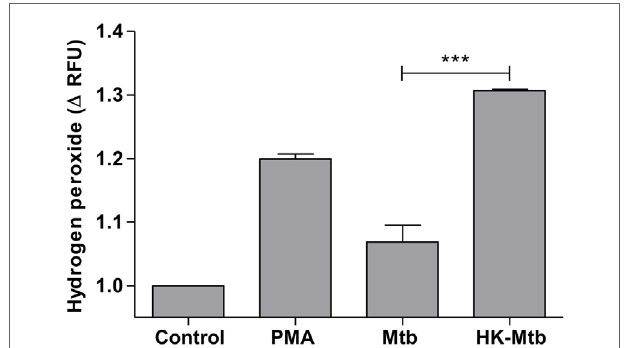
FigUre 4 | Mast cells stimulated with Mycobacterium tuberculosis (Mtb) shows low levels of hydrogen peroxide. HMC-1 cells were left unstimulated (control) or stimulated with PMA, live Mtb, or heat-killed Mtb (HK-Mtb) for 90 min and hydrogen peroxide was evaluated. The graph represents the change in fluorescence ± SD of stimulated cells compared to unstimulated cells. *** p < 0.001 as